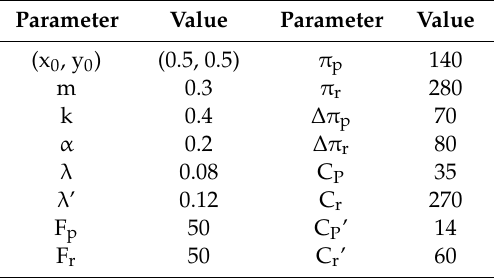
Table 10. The parameter